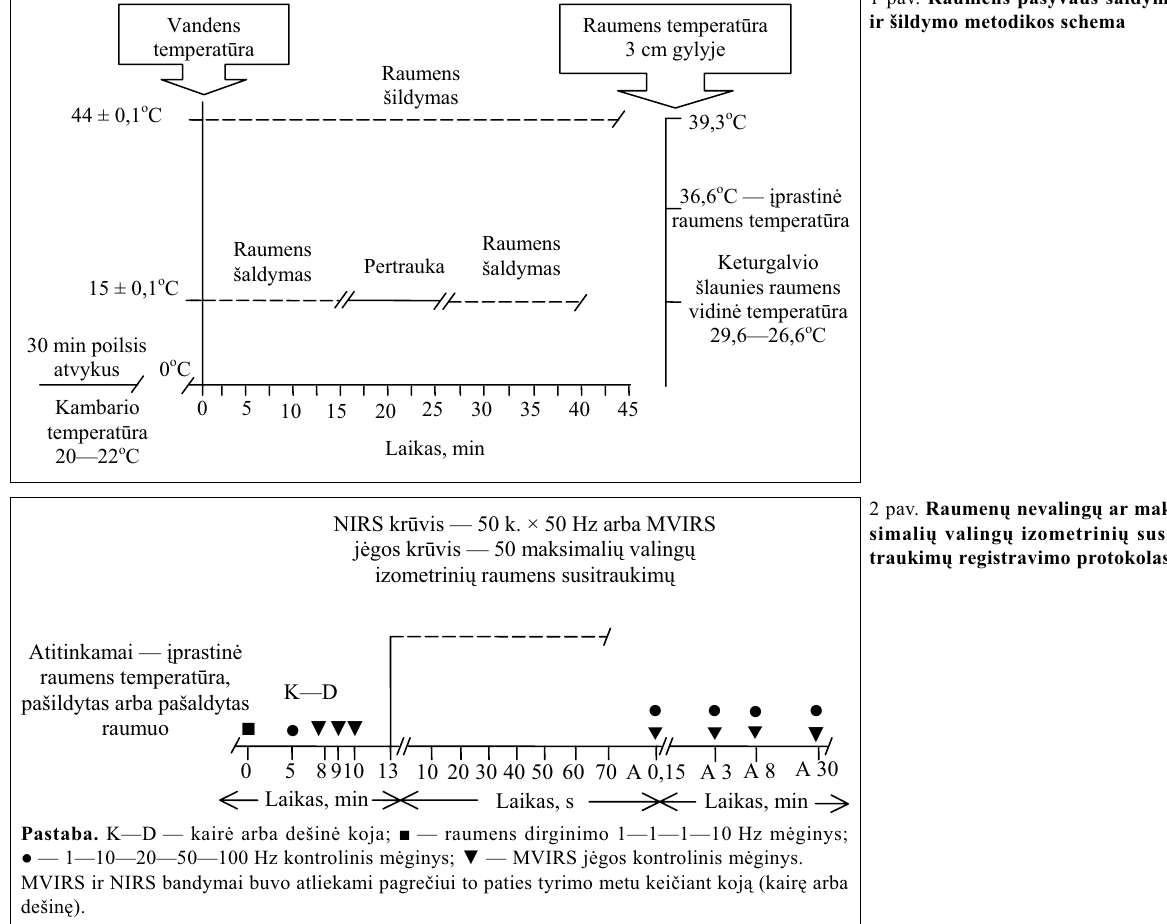
Pastaba. K—D — kairė arba dešinė koja; ■ — raumens dirginimo 1—1—1—10 Hz mėginys; ● — 1—10—20—50—100 Hz kontrolinis mėginys; ▼ — MVIRS jėgos kontrolinis mėginys. MVIRS ir NIRS bandymai buvo atliekami pagrečiui to paties tyrimo metu keičiant koją (kairę arba